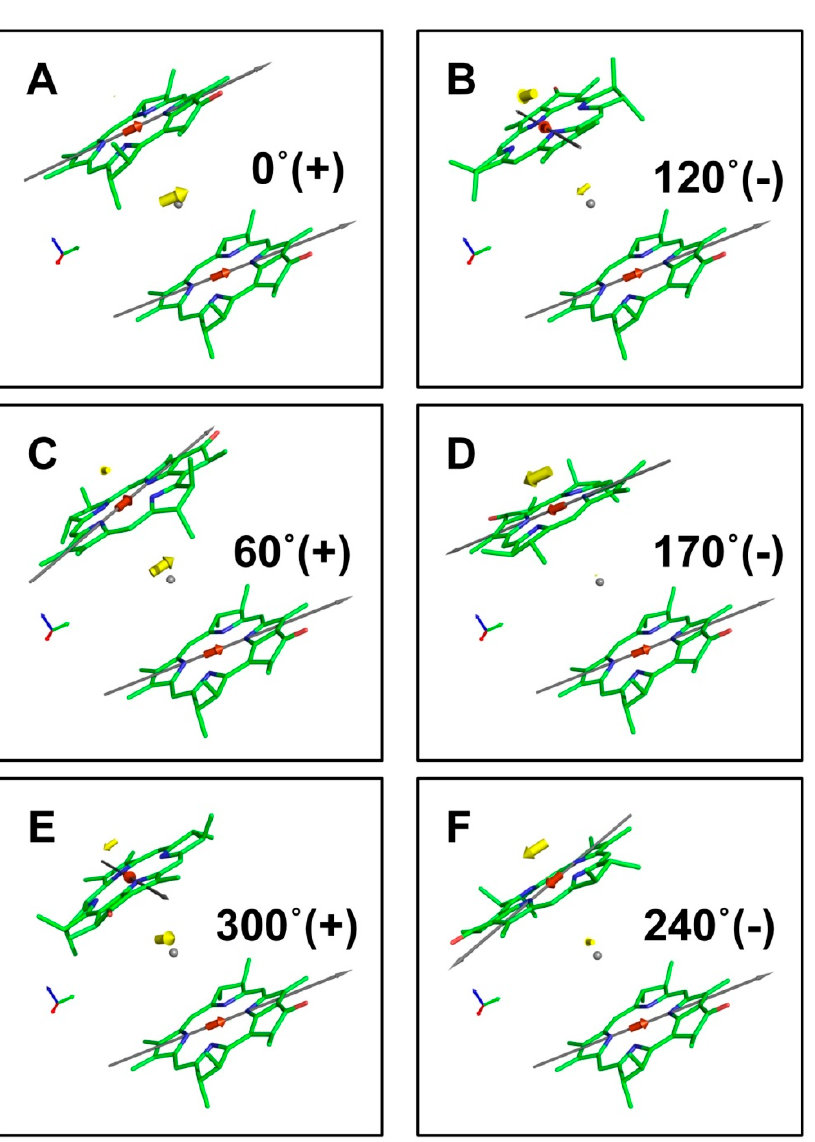
Figure 3. Q y transition moments of BChl dimer in the coordinate (red arrows) and the exciton (yellow arrows) representations. Gray arrows indicate the NB–ND direction in the pigment molecule. The angle of rotation and the sign of coupling (+/–) are shown for each configuration of BChl molecules. Gray points are the origins of coordinates. Dimer configurations with positive coupling are shown in ( A , C , E ); negative coupling in ( B , D , F ).